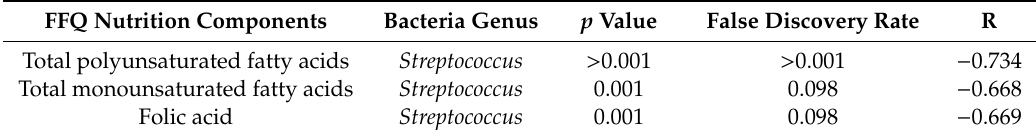
Table 1. Interactions between human milk bacteria and food frequency questionnaire (FFQ) nutrition components from the second time point—one-month post-partum.